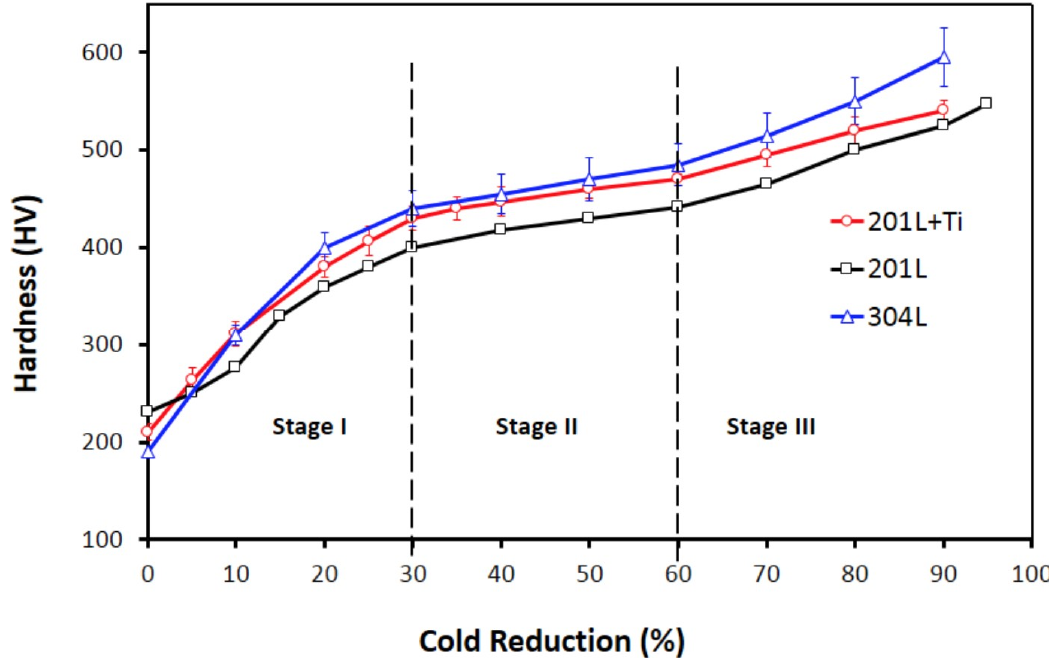
Figure 7. Hardness variation versus cold reduction percent for 304L, 201L and 201L + Ti steels.